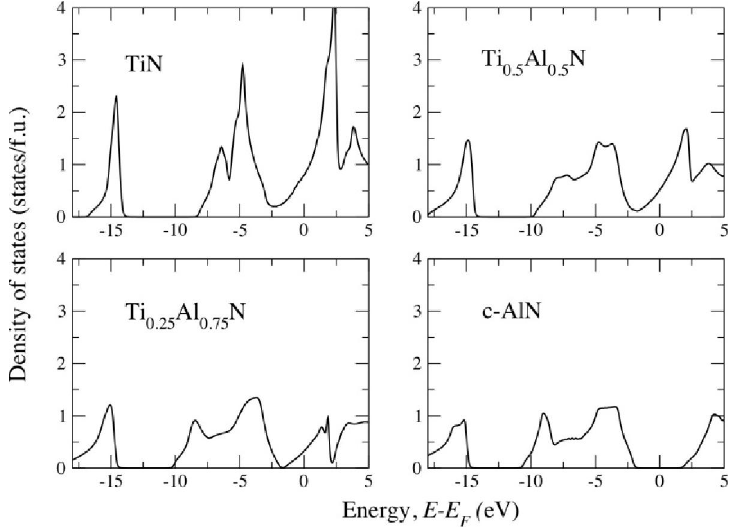
Figure 4. Total electronic density of states (DOS) for c-Ti function of energy (relative to Fermi energy E (0.00, 0.50, 0.75, and 1.00) shows the presence of the metal-to-insulator transition when one goes from metalic TiN to semiconducting